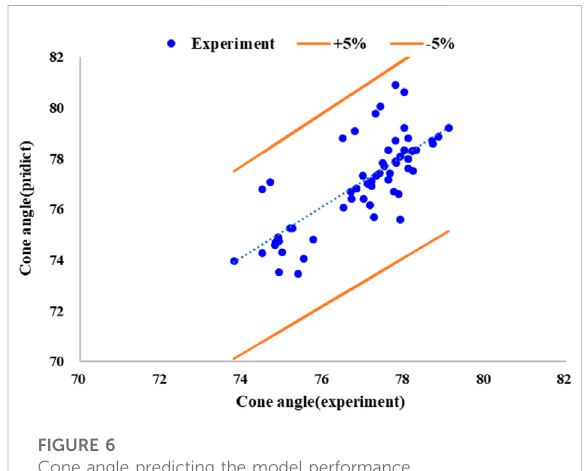
Liquid length predicting the model